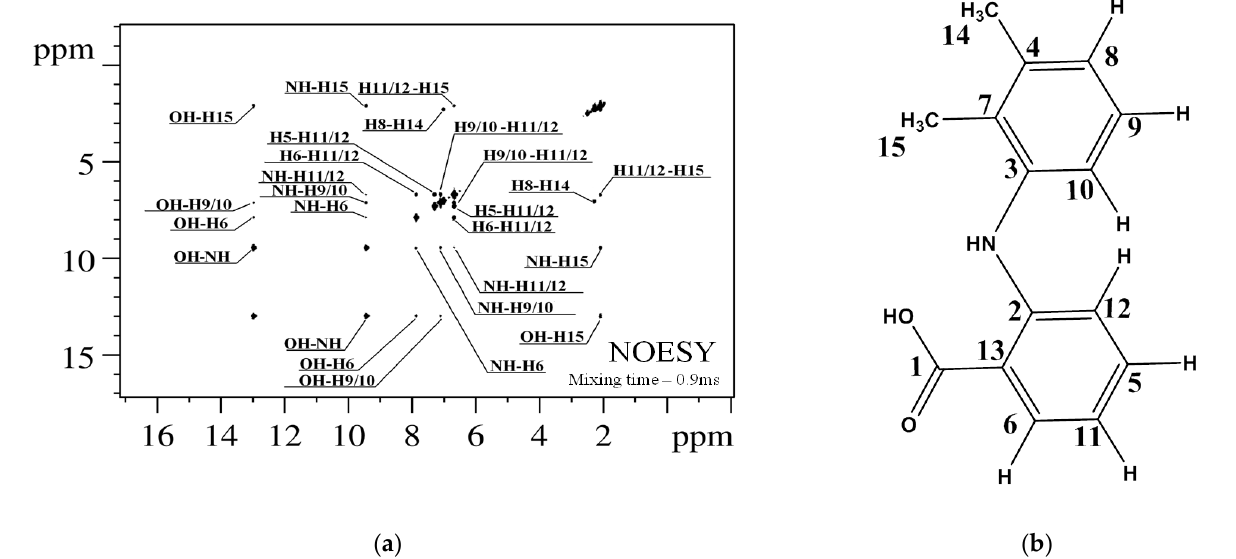
Figure 5. 1 H- 1 H NOESY NMR spectrum of MFA in DMSO-d 6 ( a ). Observed cross-peaks correspond to hydrogen atoms separated by a distance less than 5 Å . Atom numbering is shown in the right panel of the figure ( b ).